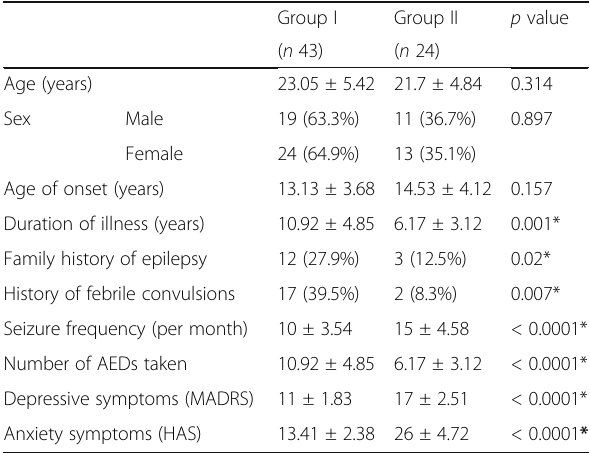
Table 1 Comparison between patients with true drug-resistant epilepsy (group I) and those with non-epileptic episodic events (group II) regarding clinical data